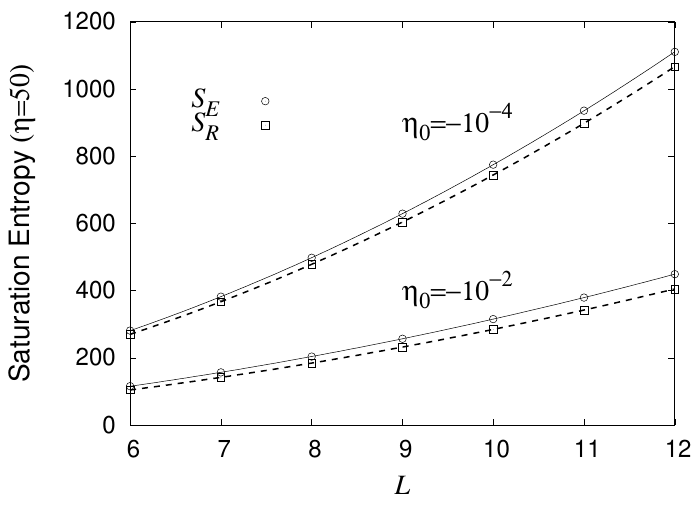
Figure 2 . Dependence of the saturation entropies, de(cid:12)ned as those at (cid:17) = 50, on L (in lattice units) for L (cid:2) L squares in the middle of a 31 (cid:2) 33 system. Circles represent the EE, and squares the second R(cid:19)enyi entropy. The lines are (cid:12)ts by quadratic polynomials bL 2 + cL + d . Larger entropies correspond to (cid:17) 0 = (cid:0) 10 (cid:0) 4 , and smaller to (cid:17) 0 = (cid:0) 10 (cid:0) 2 .